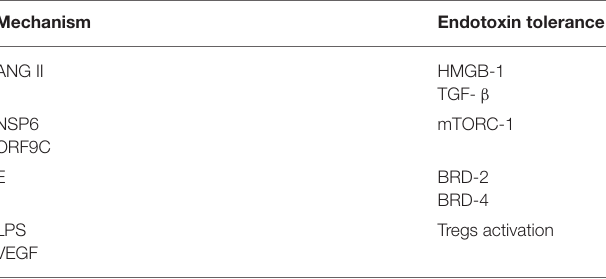
TABLE 2 | The SARS-CoV-2 immunological tolerance-inducing